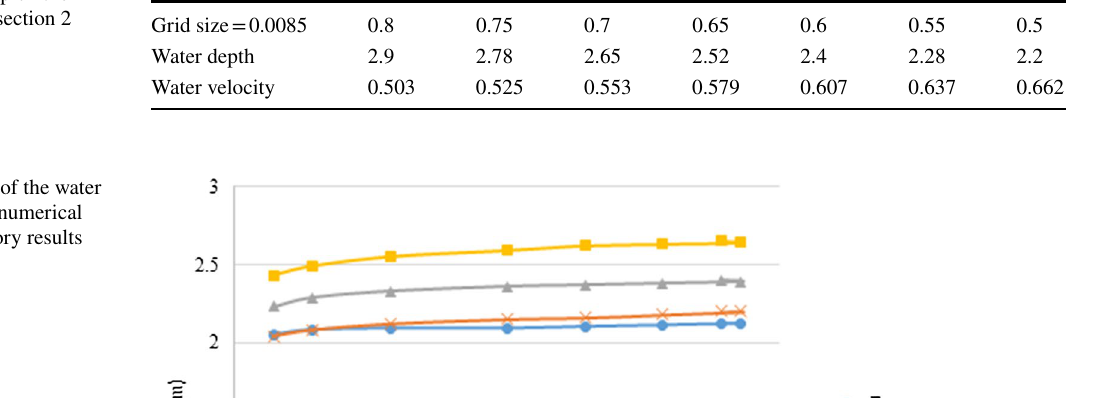
Height of the final step (m)